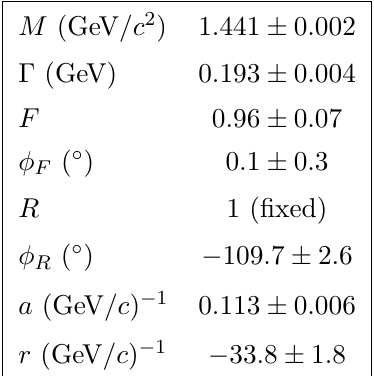
Table 6 . The Kπ S-wave parameters, obtained from the amplitude analysis of D 0 → K 0 the BABAR and Belle experiments [45]. The uncertainties are combined from the statistical and systematic